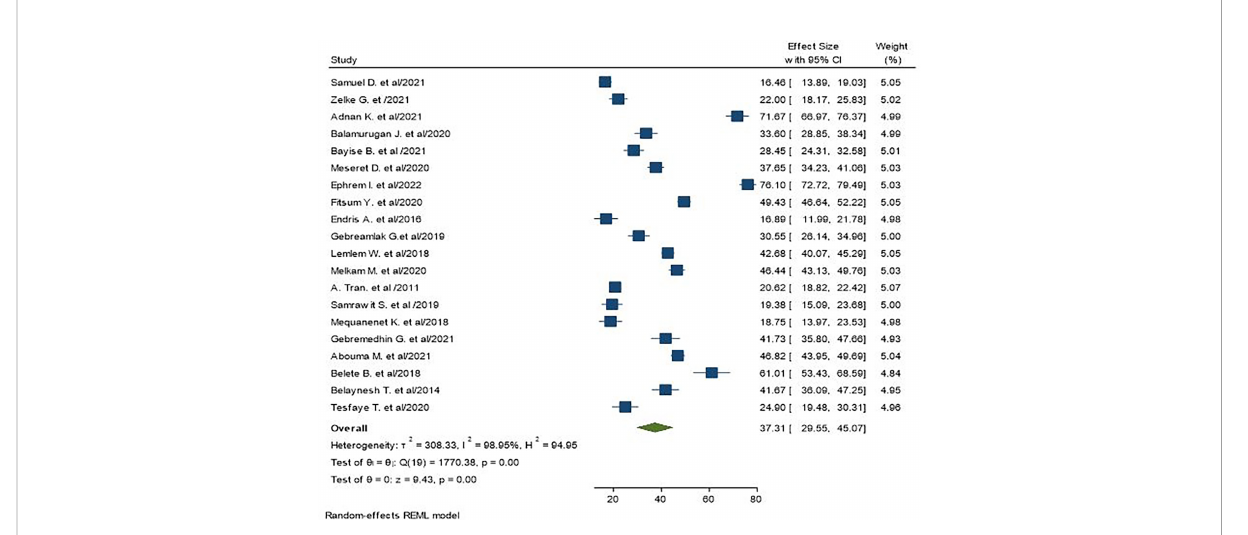
FIGURE 2 The pooled prevalence of central obesity among adult populations in